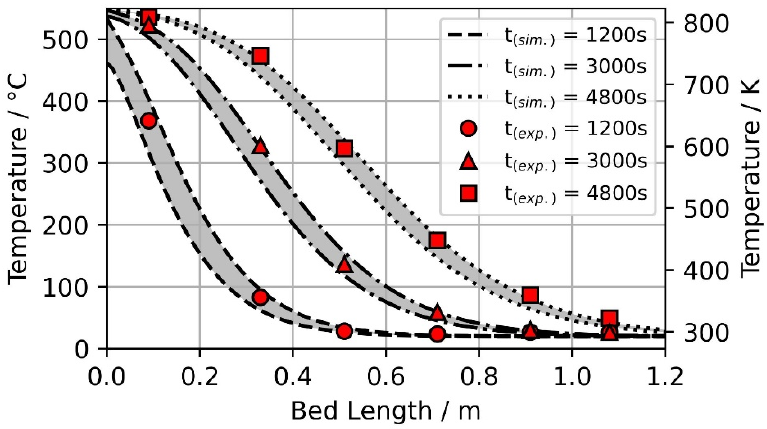
Figure 3. Model verification by comparing numerical results with experimental data published by Meier et al. [67] and reprocessed by Hänchen et al. [68]. The grey surfaces indicate the temperature difference between the solid and gaseous phases of the two-phase model.